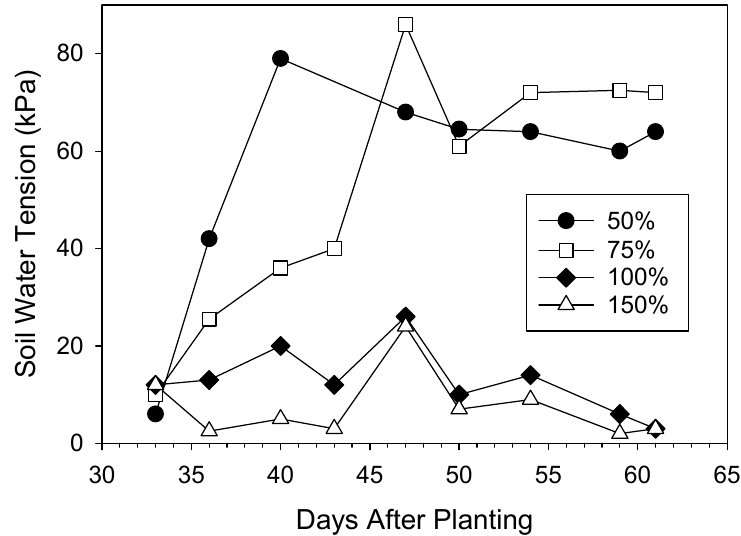
Figure 3. Soil water tension at 30 cm depth during trial 2. Symbols are an average of two replications. Higher values indicate drier soils. Treatments are 50–150% of crop water requirement. Table 4. Average tissue N content, aboveground crop N uptake, and nitrogen recovery efficiency of irrigation for both trials (data pooled across treatments) and of irrigation treatments (data pooled for both trials). Treatments are 50–150% of crop water requirement. Means with different letters are statistically different at the p < 0.05 confidence level.